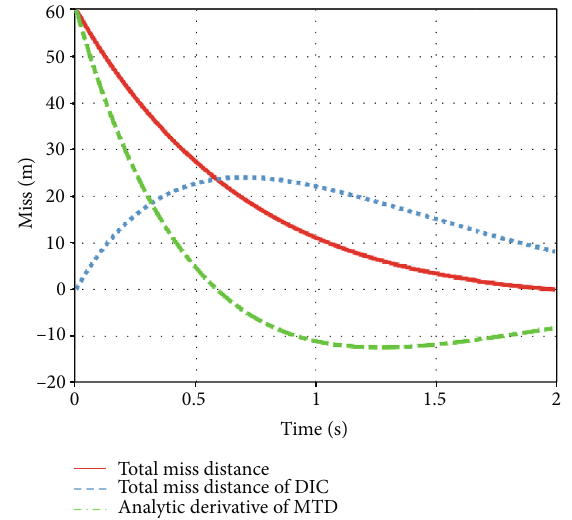
Figure 12: The change of miss distance of the numeric derivative adjoint model.